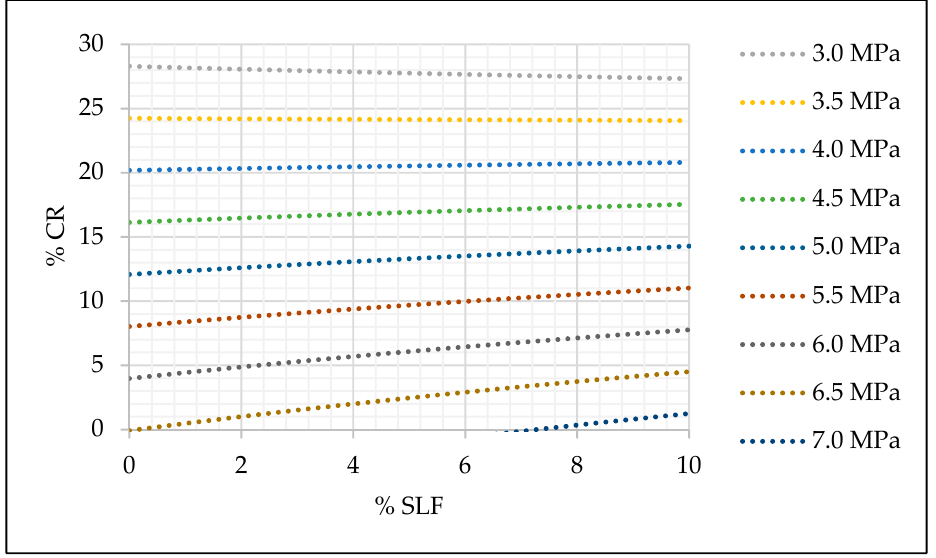
Figure 17. Prediction model for SCC flexural strength (fb = 6.489658 − 0.123341 × cr + 0.070092 × slf − 0.003003 × cr × slf).